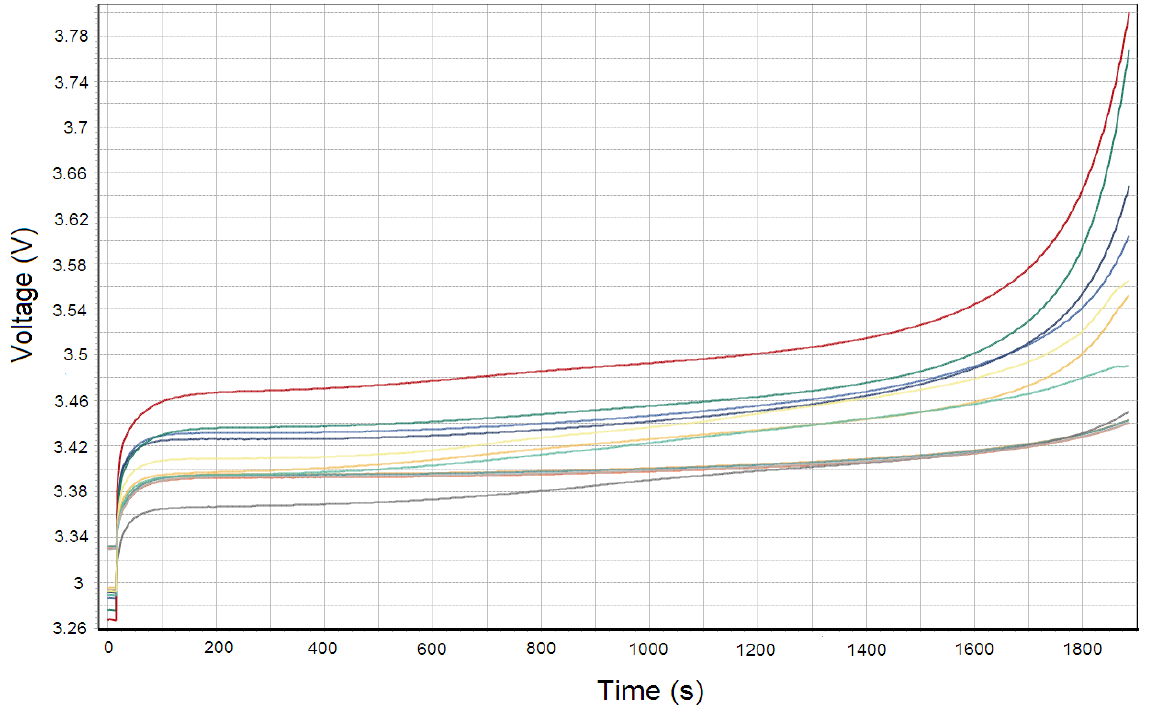
Figure 14. Increasing of variation between the cells during constant current charge without